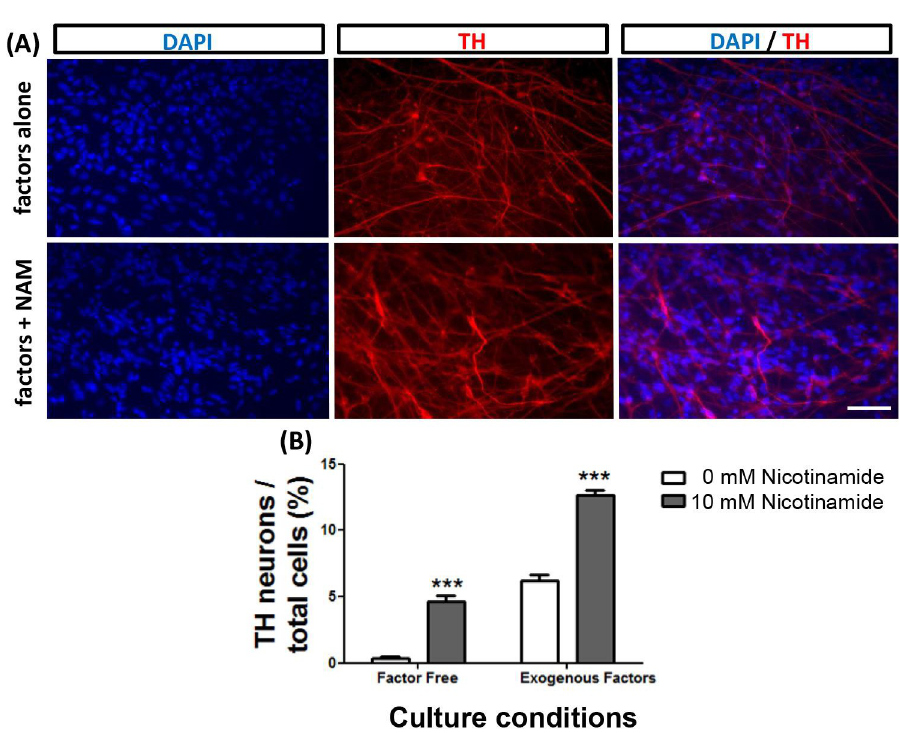
Fig 5. Nicotinamide and exogenous inductive factors act synergistically to enhance the production of TH- expressing cells from mESCs. The addition of exogenous factors to differentiating mESCs enhanced the production of dopamine neurons (A,B—white bars). Supplementation with nicotinamide induced similar TH neuron numbers as supplementation with exogenous factors; and both treatments together produced an additive effect to further increase TH neuron numbers (B—grey bars). Scale bar = 50 μ m for all images. ��� p < 0.001- comparing 10 mM nicotinamide to 0 mM